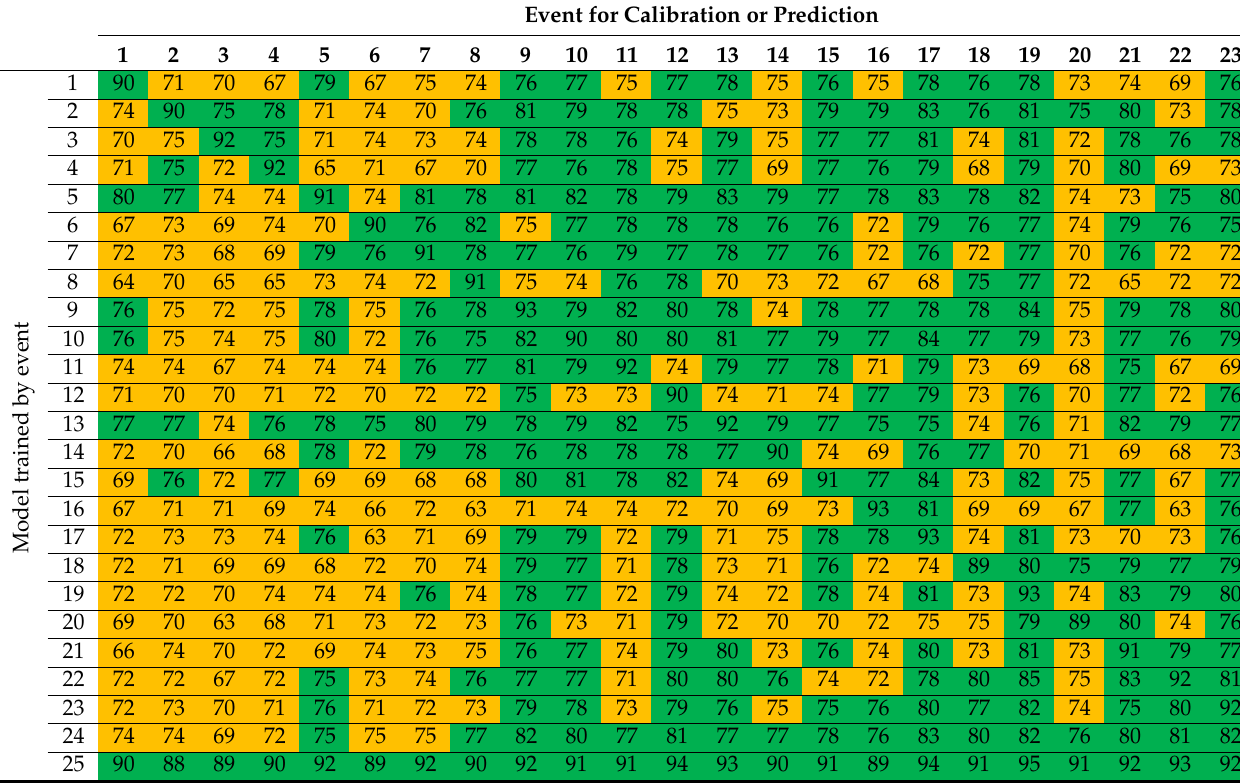
Table 9. AUROCs (%) of each PM ensemble model for the calibration or prediction of other landslide events. AUROC > 75% is indicated in green, AUROC 75–50% is indicated in